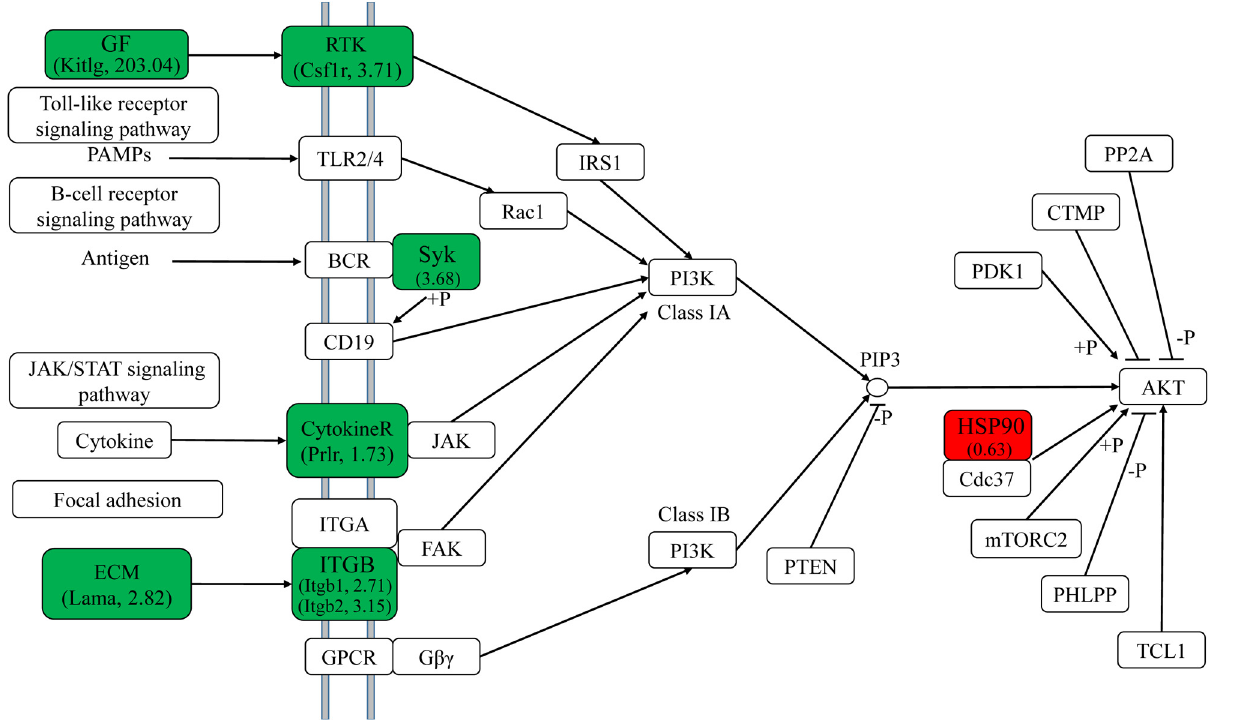
Fig 5. DEGs involved in the PI3K-AKT signaling pathway. YY highly expressed unigenes are shown in green and XY highly expressed unigenes are shown in red. The numbers in parentheses indicate the value of fold-change (RPKM value of XY/ RPKM value of YY).